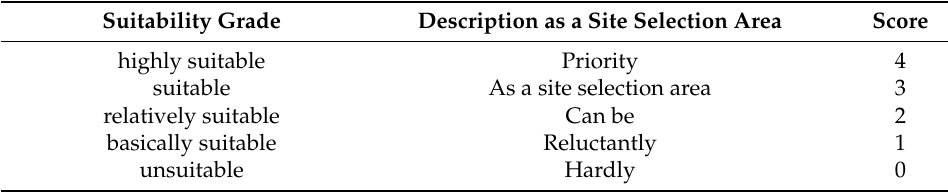
Table 2. Suitability grade of rural settlements.